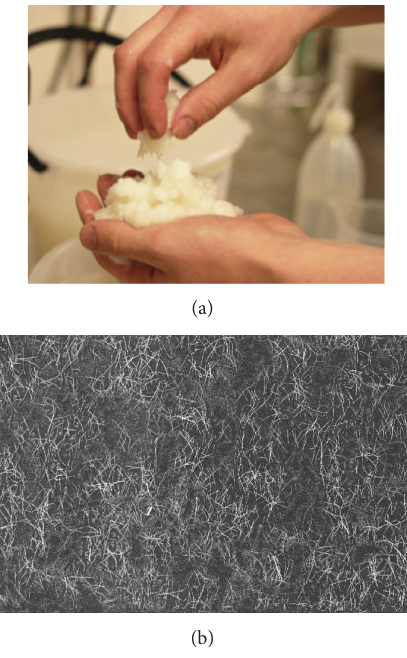
Figure 2: Wood fiber preforms: (a) pulp made from bleached softwood fibers (courtesy of Innventia, Sweden), and (b) wood fiber mat showing fiber distribution (image height ∼